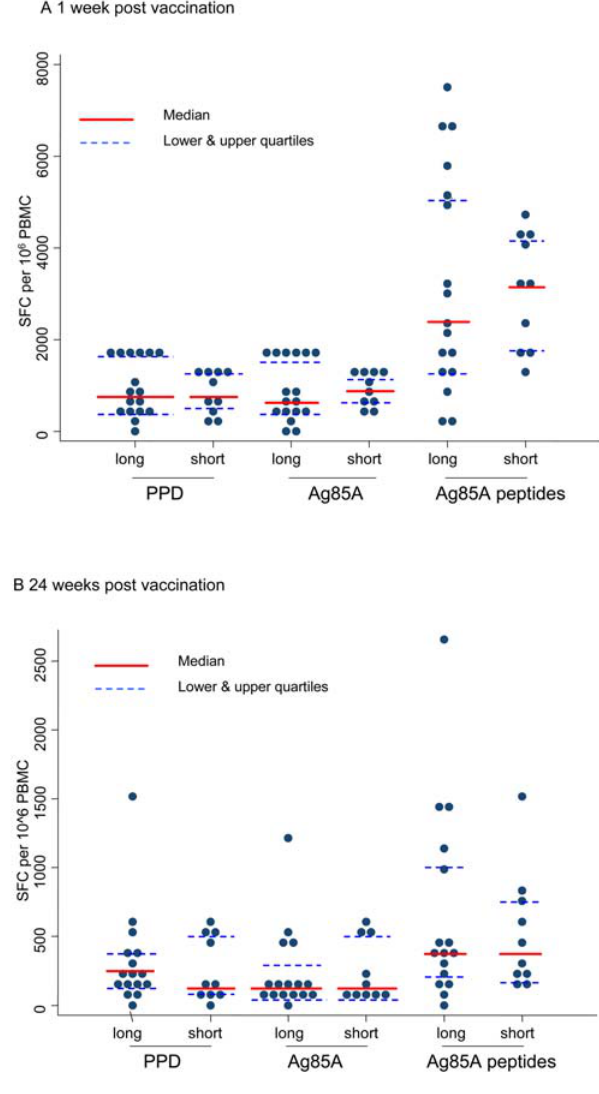
Figure 5. Dot-plot showing data at (a) 1 week and (b) 24 weeks after vaccination in the MVA85A boosted group after recent and distant BCG vaccination. Interval between BCG and MVA85A was four weeks for the short interval trial and a median of 18 years (range 6 months– 38 years) in the long interval trial. doi:10.1371/journal.pone.0001052.g005 PLoS ONE |